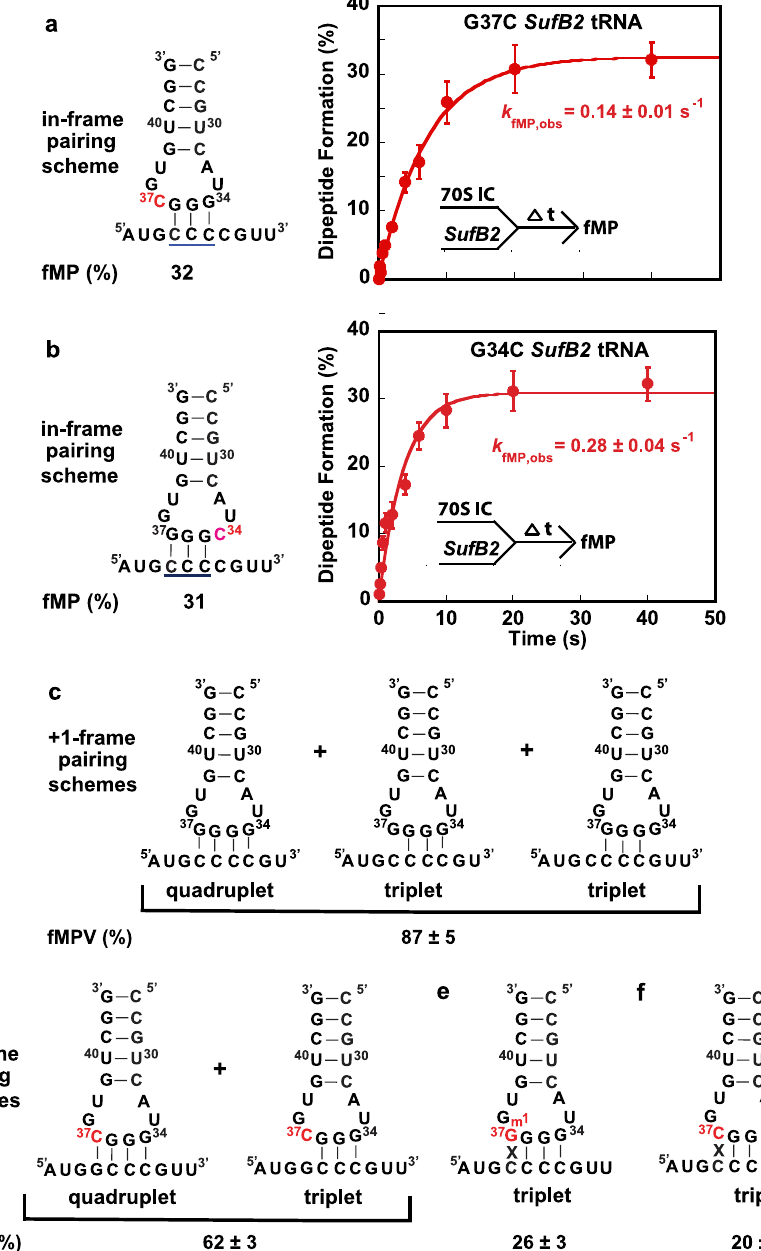
Fig. 4 Plasticity of SufB2 -induced + 1 frameshifting. a fMP formation as a function of time upon delivery of the G37C variant of G37-state SufB2 -TC to the A site of a 70S IC, allowing nucleotides 34 – 36 to pair with a CCC-C motif at the A site. b fMP formation as a function of time upon delivery of the G34C variant of G37-state SufB2 -TC to the A site of a 70S IC, allowing nucleotides 35 – 37 to pair with a CCC-C motif. c – f Results of fMPV formation assays in which SufB2 -TC is delivered to an A site programmed with a quadruplet codon at the 2nd position and sequences of the SufB2 anticodon loop and/or quadruplet codon are varied. Yields of fMPV formation represent + 1 frameshifting during translocation of SufB2 from the A site to the P site. Possible + 1- frame anticodon-codon pairing schemes of SufB2 during translocation: c G37-state SufB2 capable of frameshifting at a CCC-C motif via quadruplet pairing and/or triplet slippage, d G37C variant of G37-state SufB2 capable of frameshifting at a GCC-C motif via quadruplet pairing and/or triplet slippage, e m 1 G37-state SufB2 capable of frameshifting at a CCC-C motif via only triplet slippage, and f G37C variant of G37-state SufB2 capable of frameshifting at a CCC-C motif via only triplet slippage. In a , b the bars in the graphs are SD of three ( n = 3) independent experiments, and the data are presented as mean values ± SD. Δ t: a time